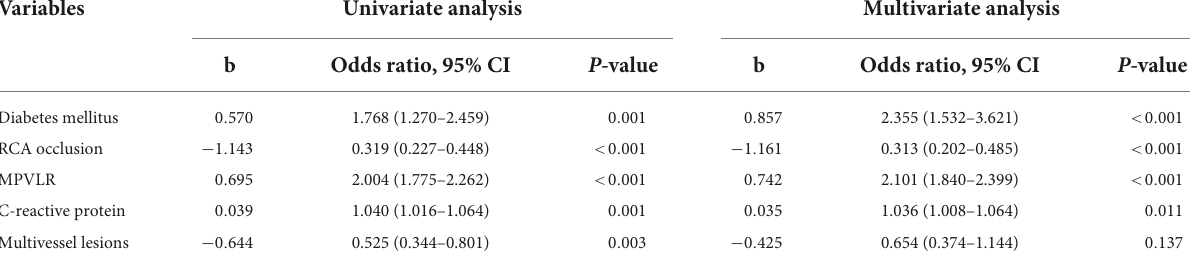
TABLE 4 Univariate and multivariate logistic regression analyses of poor coronary collateral circulation in CTO